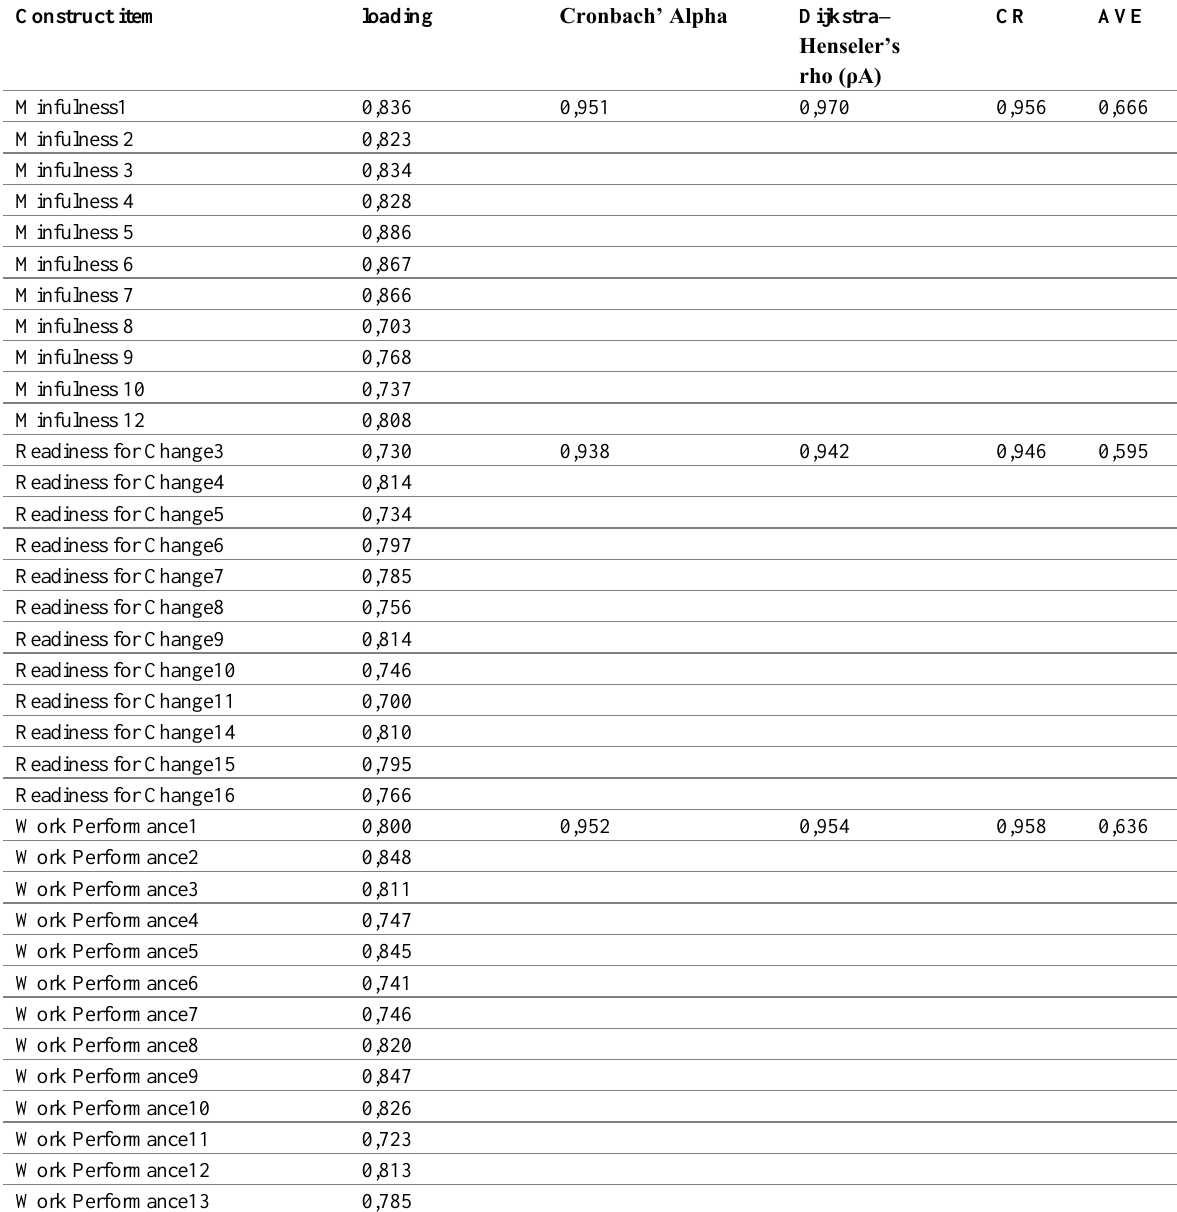
Table 1: Loading Factor and level of internal consistency in each construct